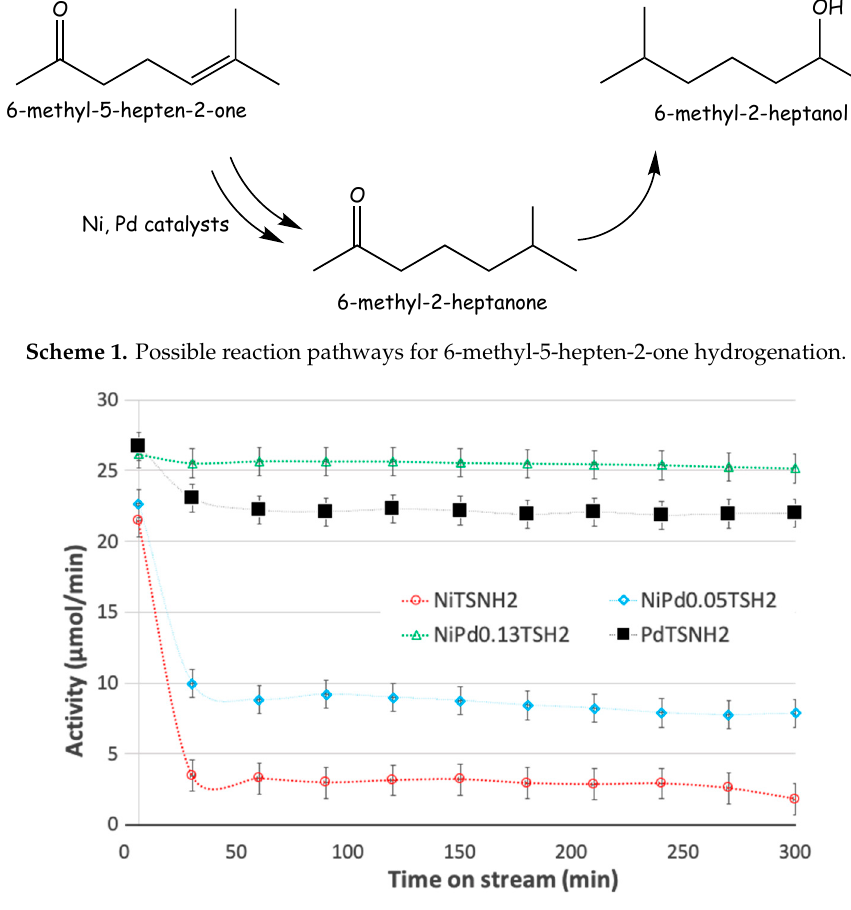
Figure 7. Catalytic activity in the conversion of 0.05 M 6-methyl-5-hepten-2-one at 100 ◦ C and 40 bar of hydrogen with a reactant flow rate of 0.5 mL / min (25 µ mol / min), except for PdTSNH 2 that was tested under optimal conditons, namely 10 bar hydrogen and 85 ◦ C.